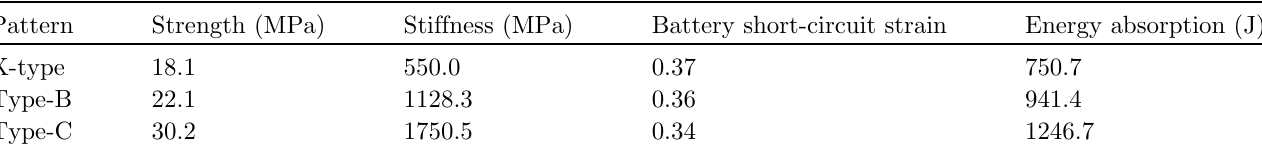
Table 1. Summary of mechanical properties of the multifunctional metamaterial system with different phase